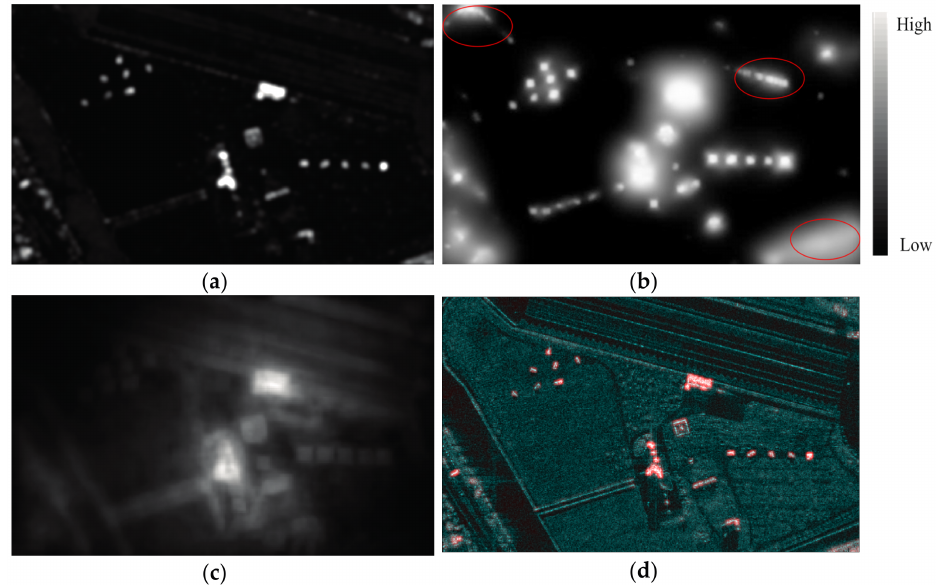
Figure 4. Saliencymapgenerationresultsofdifferentmethods. ( a )Theproposedmethod; ( b ) The IVSaliency method; ( c ) The PRSaliency method; ( d ) Original SAR image overlaid with the salient map of ( a ), where the red regions are